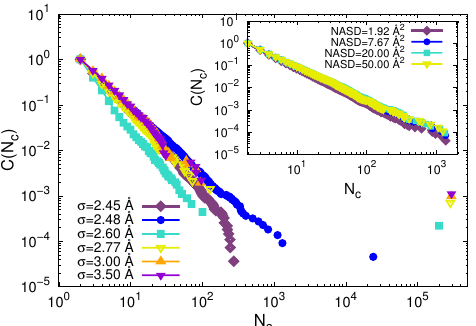
Figure A2. Cumulative distribution C ( N c ) of cluster sizes N c for different values of σ . Inset: Cumulative distribution C ( N c ) of cluster sizes N c for different selections of the NASD parameter NASD cutoff